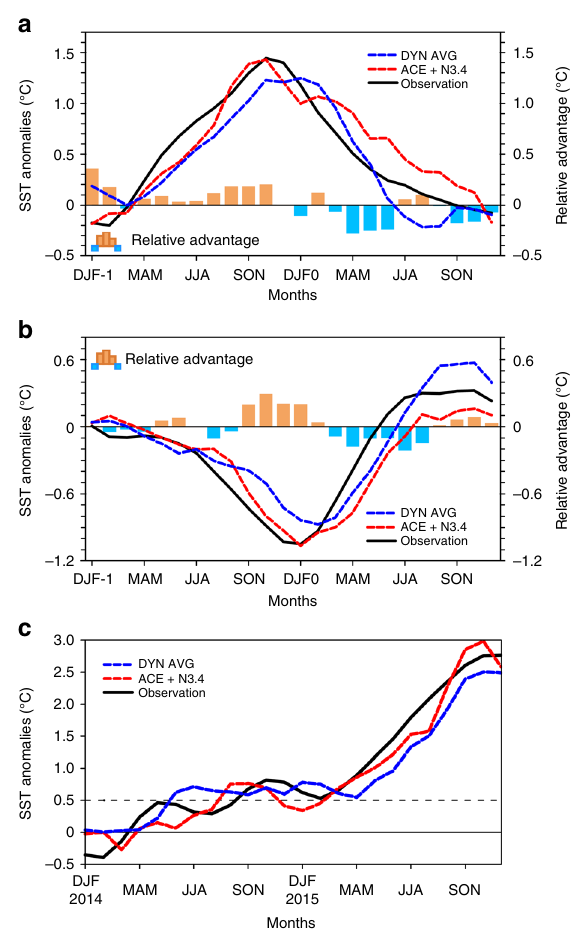
Fig. 9 Time series of the running 3-month mean SST anomaly for the Niño 3.4 region (5°N − 5°S, 120° − 170°W) (N3.4, an ENSO index, °C) for observations and predictions. a Composite time series of N3.4 for all El Niño events in the hindcasting period (2002 – 2016). The blue dashed line is the average prediction by dynamical models, and the red line the ACE + N3.4 model. The black solid line is the observations. Bars indicate the amplitude of the models ’ relative advantage between the average of the dynamical models and the ACE + N3.4 model. Blue (orange) bars represent the advantage of the dynamical models average relative to the ACE + N3.4 model (ACE + N3.4 model relative to dynamical models average).